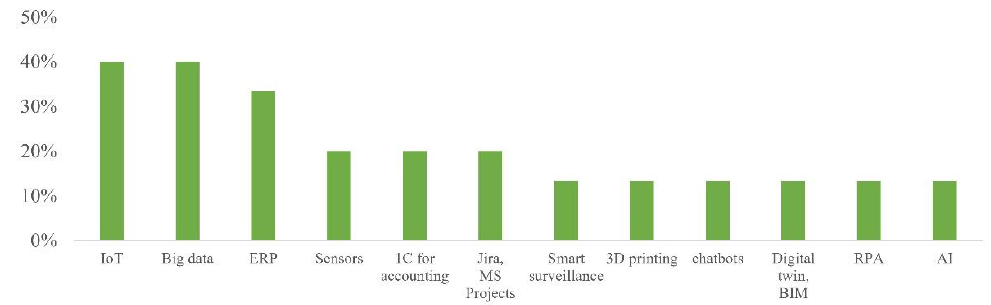
Figure 5. The most demanded technologies and tools of Industry 4.0 in Kazakhstan.